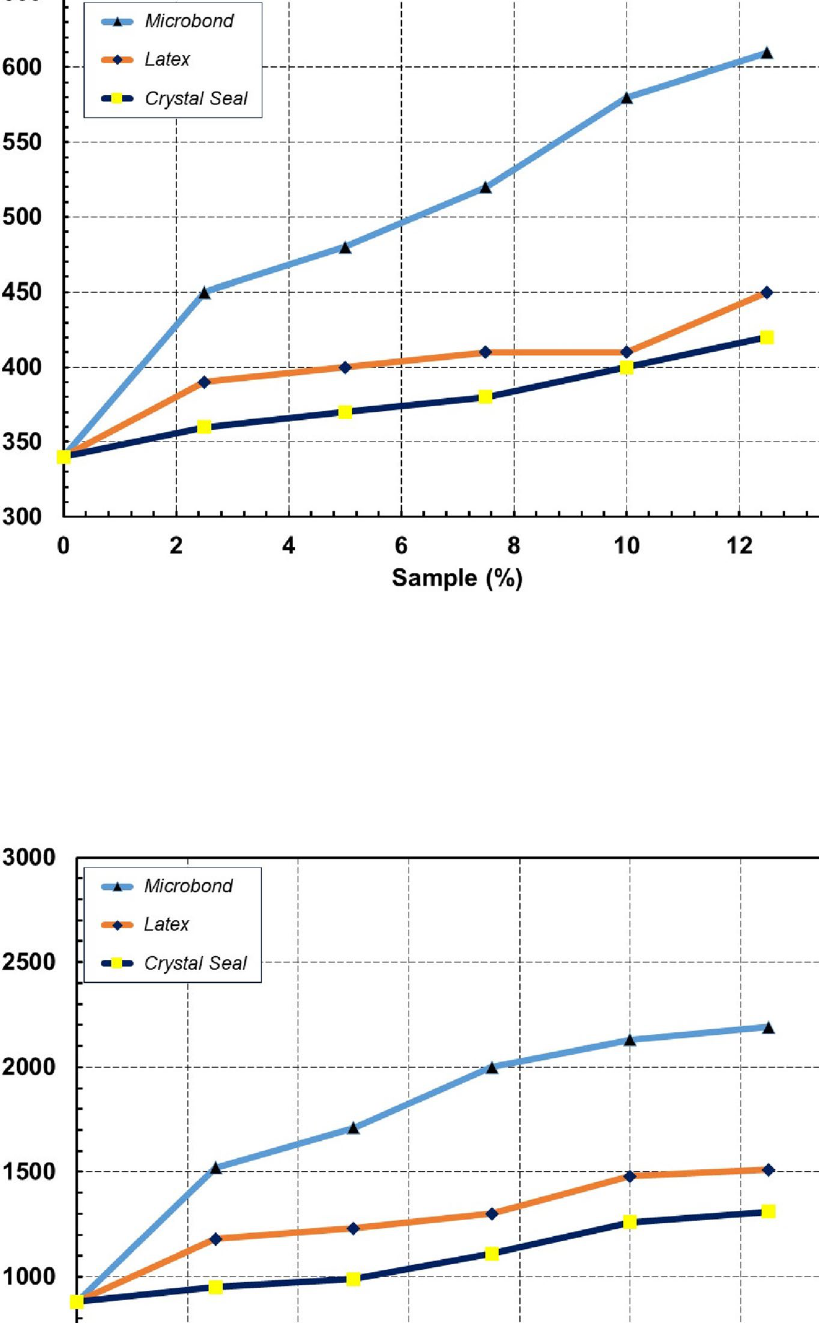
Fig. 17 Additives comparison, ultimate compressive strength